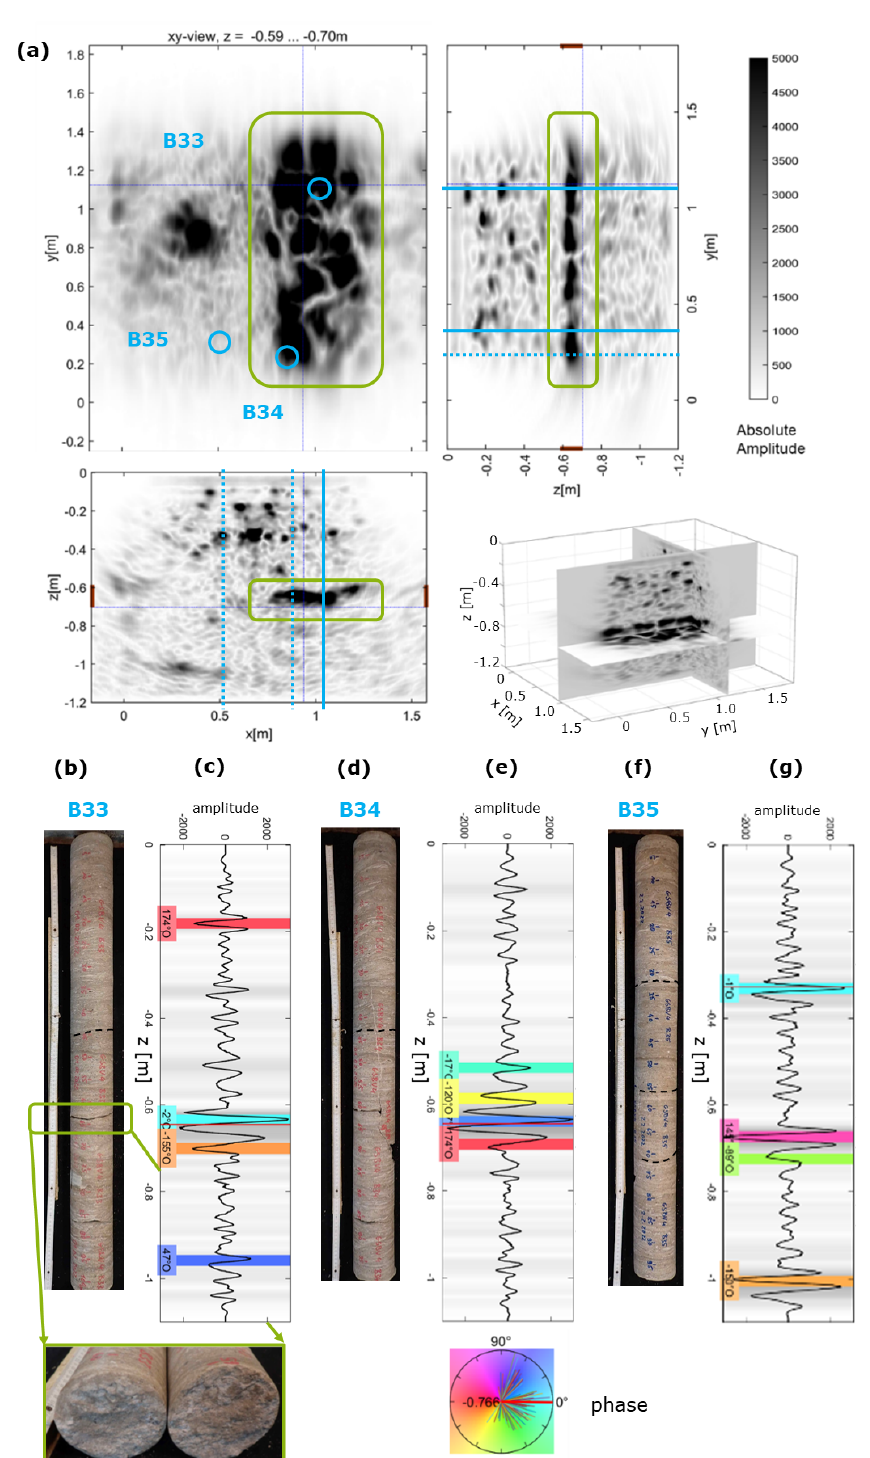
Figure 10. Ultrasonic imgaging results of GSBV4: ( a ) equivalent to Figure 9 at a summed depth interval of z = 0.59–0.7 m. Note the location of drilled boreholes (blue) and large reflector (green rectangle). ( b , d , f ) taken cores with ( c , e , g ) corresponding phase analysis at the same